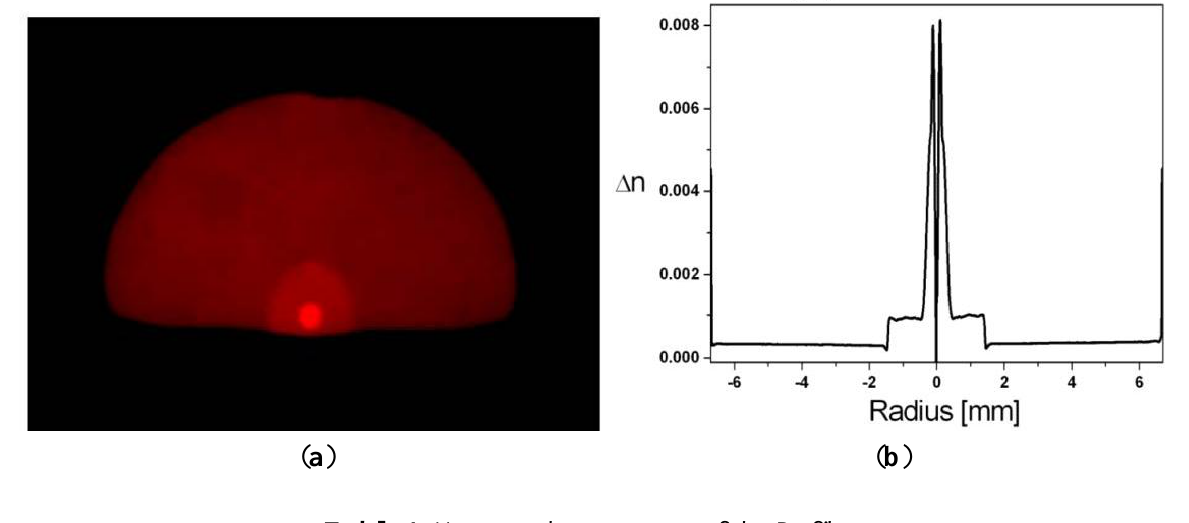
Figure 1. ( a ) Optical image of illuminated D-fibre cross-section; ( b ) corresponding refractive index profile of the preform.